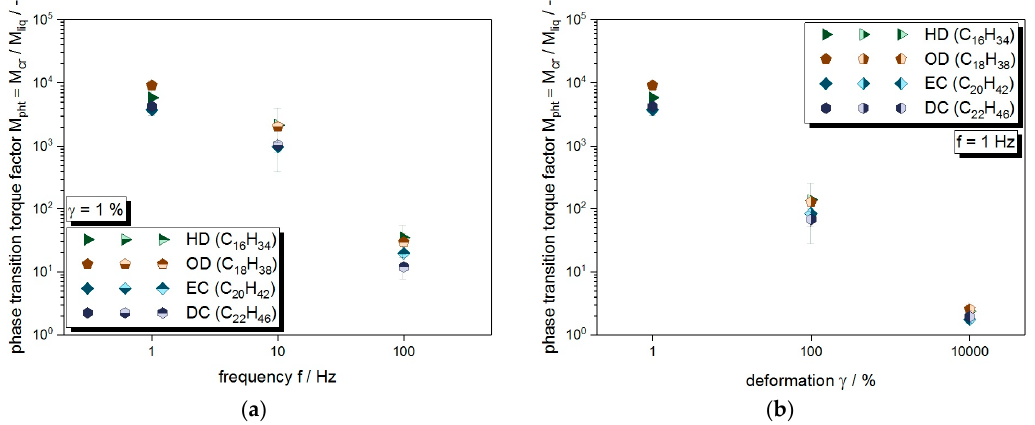
Figure 6. ( a ) Phase transition torque factor of 10 wt % alkane dispersions M pht as a function of frequency f ; ( b ) Phase transition torque factor of 10 wt % alkane dispersions M pht as a function of deformation γ .